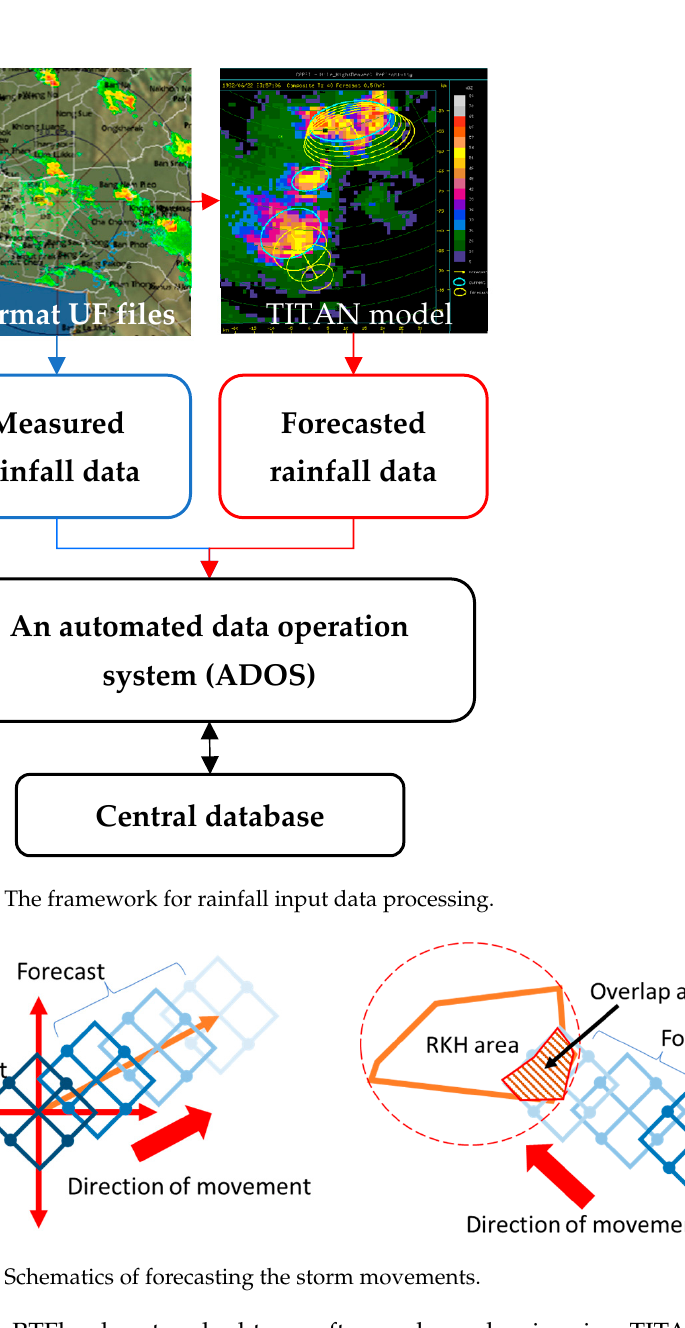
Figure 6. The flowchart of an automated data operation system (ADOS). 2.2.3. Module 3: Hydraulic Model Processing PCSWMM sits on an open-source GIS to facilitate hydrologic and hydraulic attribute inputs, outputs, and data management and has comprehensive flow modeling tools, i.e., a real-time control analysis, time series management, Digital Elevation Model (DEM) sup- port, automated reporting, and Google Earth visualization for hydrology, hydraulics, and water quality modeling [105,106]. It could also model stormwater pollutant source control technologies to predict water quantity and quality [96]. Therefore, PCSWMM was adopted for this study to investigate flash floods in terms of their locations and depths within the Ramkhamhaeng polder. It would be possible to use other physically based con- ceptual models for the hydrology and hydraulics of the system within the RTFlood plat- form, and efforts to provide this option will be explored as a goal of future research efforts.